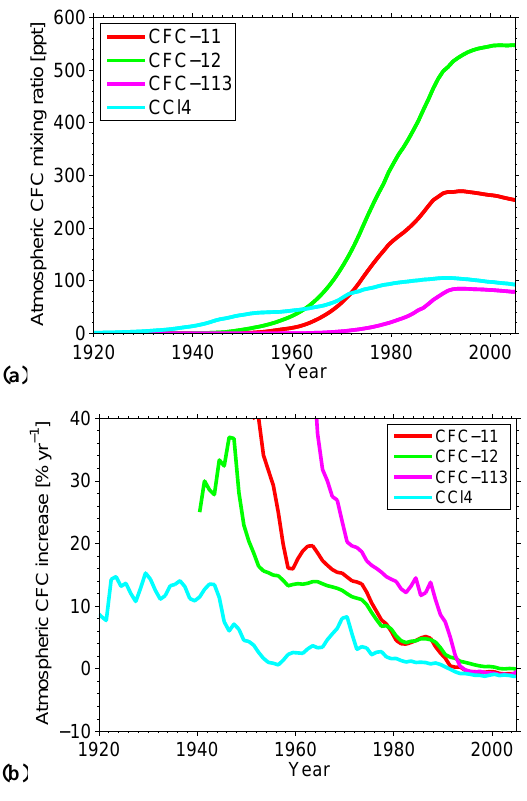
Figure 3. (a) Atmospheric CFC time histories, (b) Relative an- nual CFC increase rates. Atmospheric CFC data are from Walker et al. (2000).